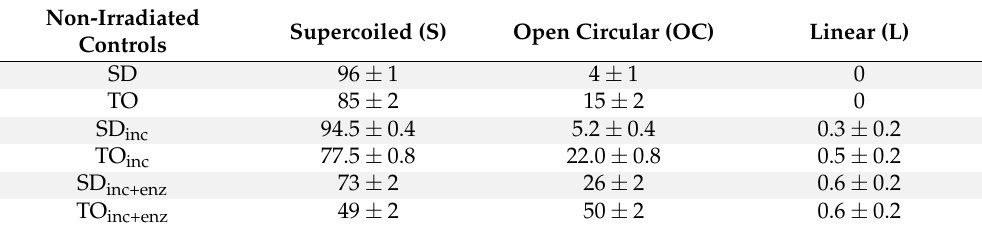
Table 1. DNA yields for the control DNA kept in San Diego (SD) and the control DNA sent to Toronto (TO). DNA incubated at 37 ◦ C for 1 h before agarose gel electrophoresis analysis is denoted by the subscript “inc”, and DNA incubated with enzymatic (Fpg and Nth) treatment at 37 ◦ C for 1 h is denoted by the subscript “inc + enz”). Uncertainties represent the sample standard deviation.